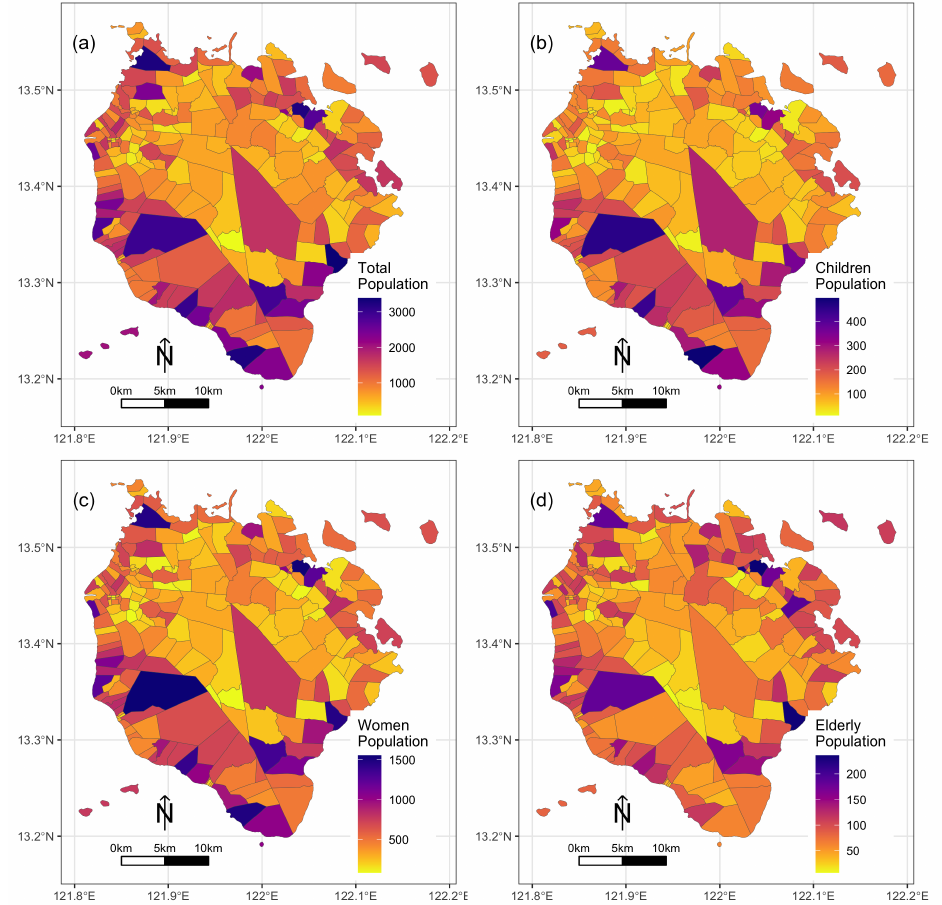
Figure 2. Map of the population distribution of different population groups in the province of Marinduque: ( a ) general population; ( b ) children; ( c ) women; and, ( d )